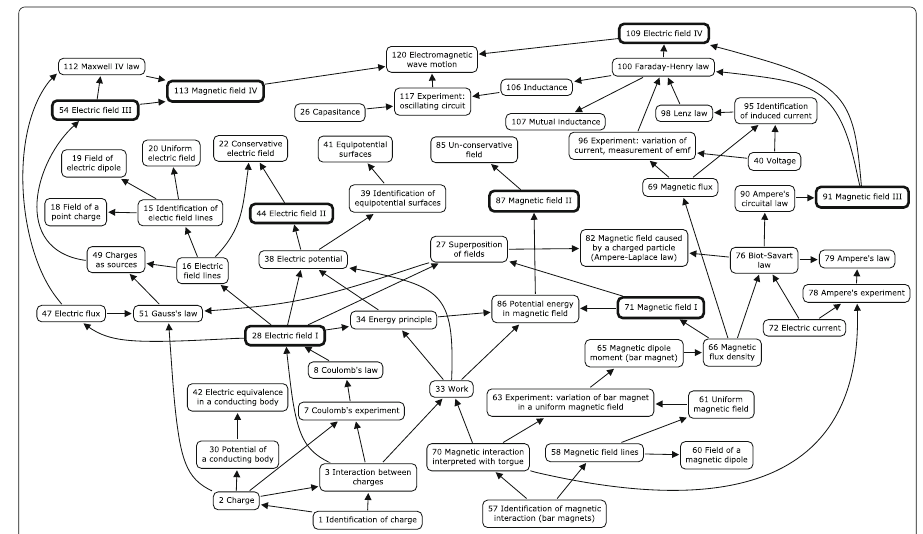
Fig. 1 An example of an individual concept map. A concept map constructed by one student, shown (redrawn for clarity) to illustrate the overall appearance of the maps. The content of the links is not essential here